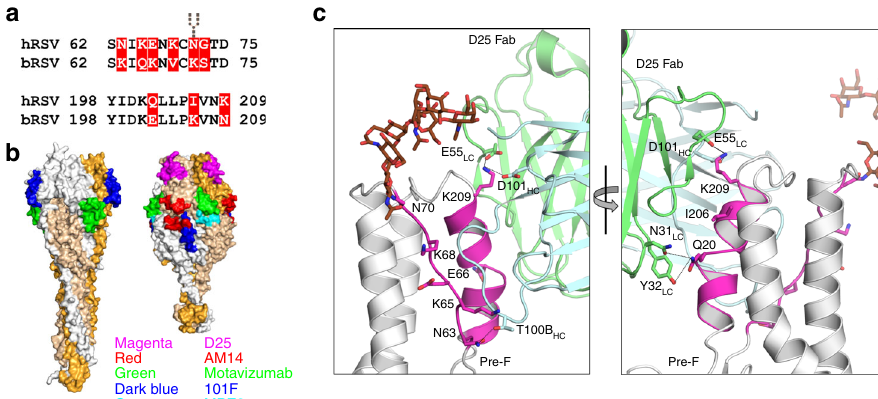
Fig. 1 Neutralizing epitopes of human and bovine RSV F proteins. a Sequence alignment of Site Ø residues with differences between hRSV and bRSV F highlighted in red. The glycosylation site at N70 of hRSV F is indicated with a branched carbohydrate symbol. b Neutralizing epitopes of hRSV F mapped on the surface of post-fusion (left) and pre-fusion (right) models of the bovine counterpart. Individual monomers in each trimer are colored white, tan and orange. Epitopes depicted are for the following monoclonal antibodies: Motavizumab (Site II, green), 101F (Site IV, dark blue), D25 (Site Ø, magenta), MPE8 (cyan) and AM14 (red). c Molecular detail of Site Ø (magenta) in human RSV F with residues that differ from bRSV F and the corresponding key contact residues in D25 (light blue and green) shown as sticks. Dotted lines represent hydrogen bonds between antigen and antibody. HC heavy chain, LC light